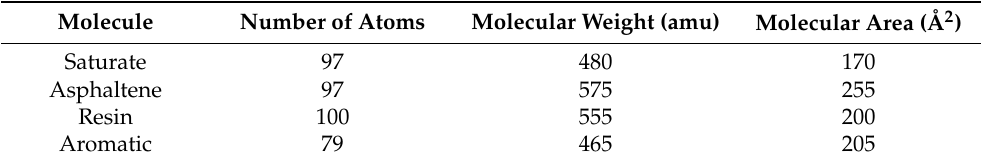
Table 1. The number of atoms, molecular weight, and surface area of SARA components (adapted from